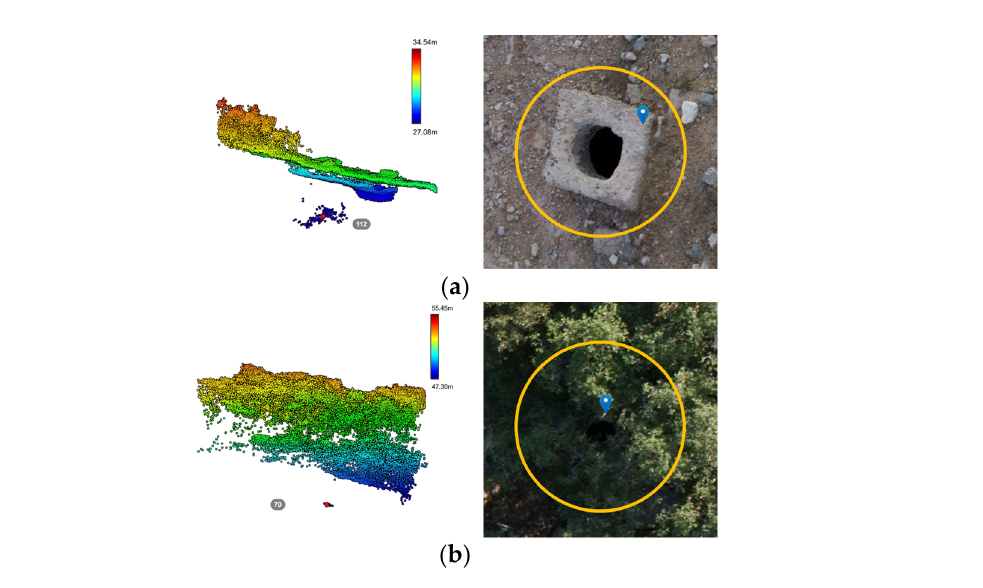
Figure 29. Samples of detected cistern locations (red dots) in the LiDAR point cloud and images where they should be visible: ( a ) the cistern is clearly visible in the image and ( b ) the cistern is not visible in the image due to canopy cover.